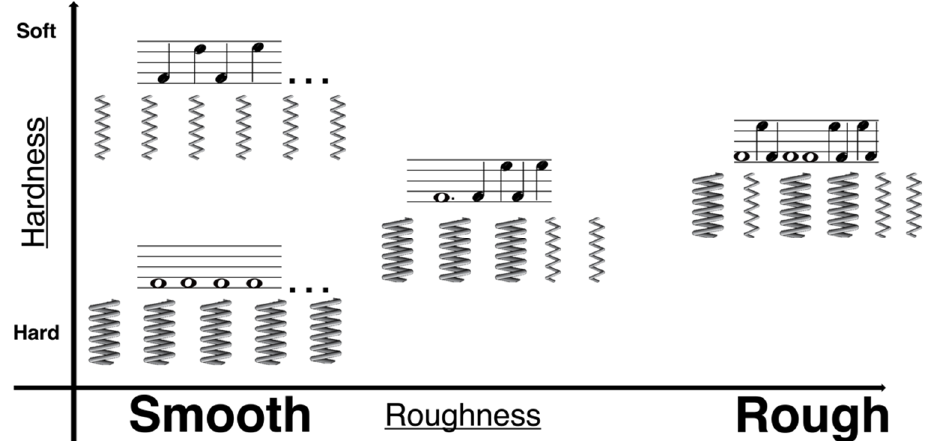
Figure 2. The vertical axis indicates hardness—harder at the bottom, softer at the top. The horizontal axis indicates roughness—the more uniform the hardness, the smoother the Tactile Score pattern; the more non-uniform the hardness, the rougher the